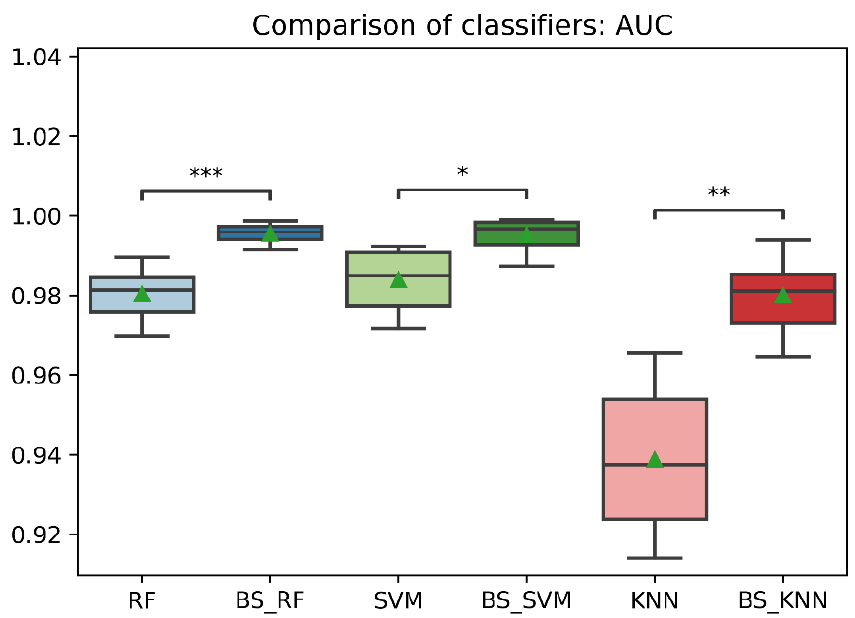
Figure 12. Comparison of AUC between classification models with imbalanced and oversampled data. RF = Random Forest; BS_RF = Borderline-SMOTE Random Forest; SVM = Support Vector Machine; BS_SVM = Borderline-SMOTE Support Vector Machine; KNN = K-nearest Neighbors; BS_KNN = Borderline-SMOTE K-nearest Neighbors; *: p ≤ 0.05; **: p ≤ 0.01; ***: p ≤ 0.001.